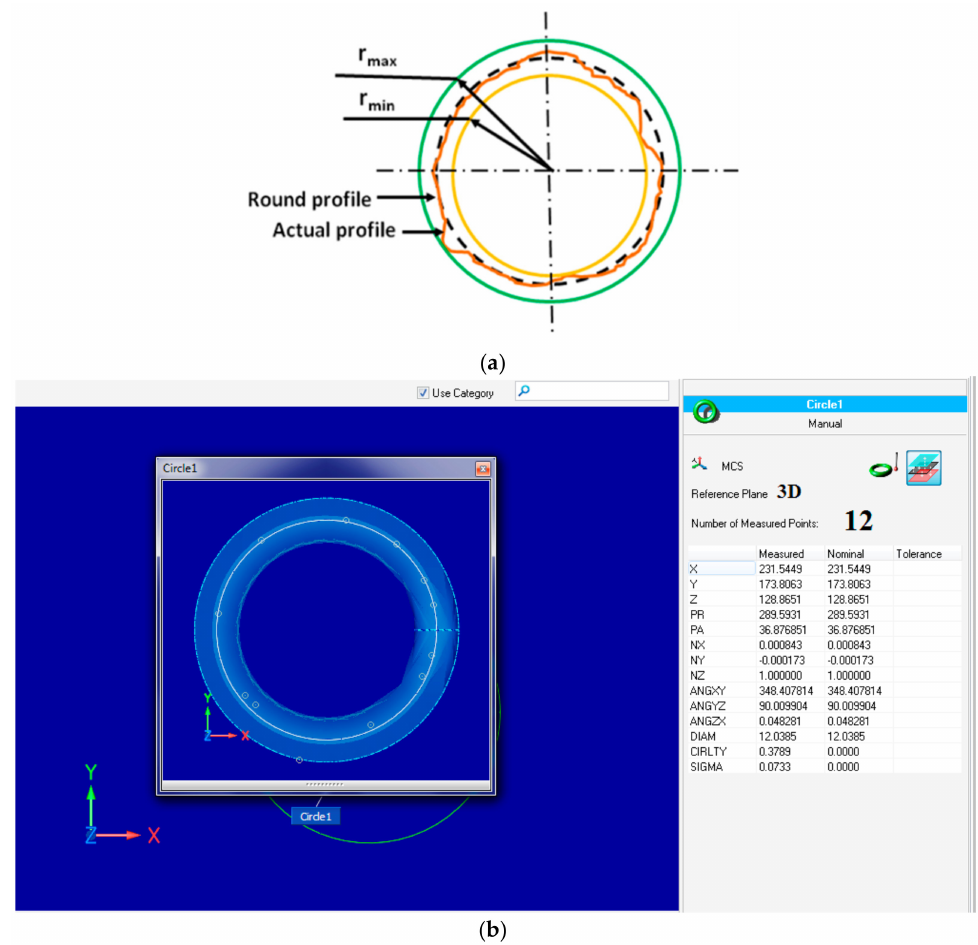
Figure 4. ( a ) Schematic of tool profile [21]. ( b ) Measurement of OOR using